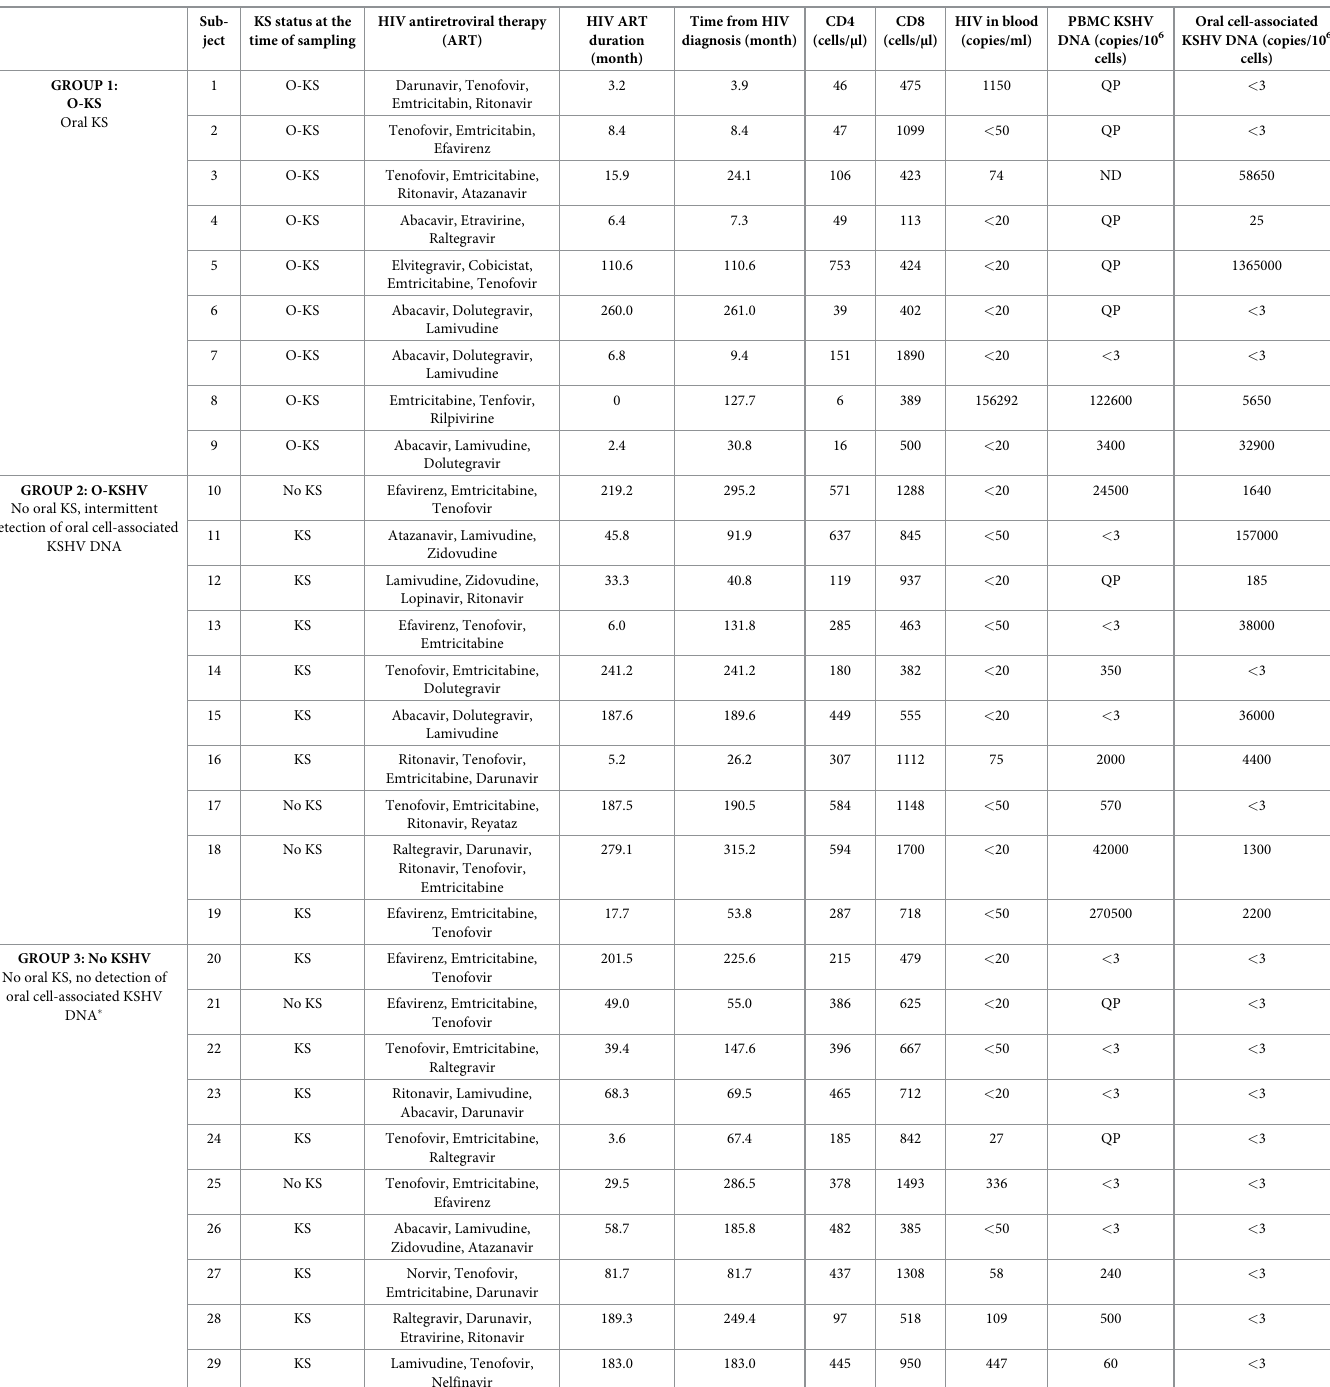
Table 1. Clinical characteristics of HIV/KSHV-coinfected individuals. Sub- ject GROUP1: O-KS